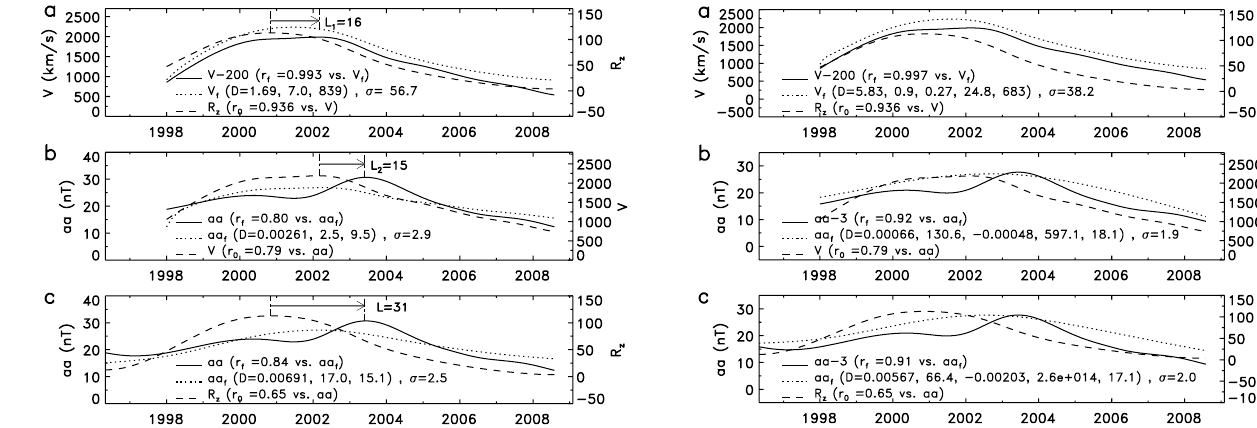
Fig. 8. (a) Monthly mean of integrated daily CME linear speed V − 200 (solid, shifted downward by 200 for clarity) and R z (dashed) smoothed with a 24-month Gaussian filter. The dotted line shows the reconstructed series ( V f ) from January 1998 to September 2008 by Model (10). The correlation coefficients of V with R z and V f are r 0 = 0 . 936 and r f = 0 . 993, respectively. The lag time of V to R z (at maximum) is L 1 = 16 (months). (b) Similar results for the relationship between aa (solid) and V (dashed). The correlation coefficients of aa with V and the reconstructed series aa f are r 0 = 0 . 79 and r f = 0 . 80, respectively. The lag time of aa to V is L 2 = 15 (months). (c) Similar results for the relationship between aa (solid) and R z (dashed). The correlation coefficients of aa with R z and the reconstructed series aa f are r 0 = 0 . 65 and r f = 0 . 84, respectively. The lag time of aa to R z is L = 31 (months). Other numbers indicate the fitted parameters ( D , τ , y 0 ) and σ .